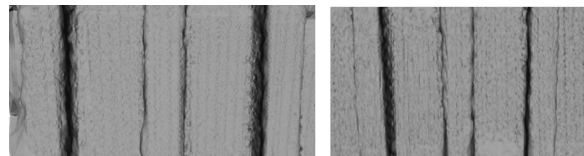
Figure 9: Comparison between our combined method and maxi- mum min-SW gray code